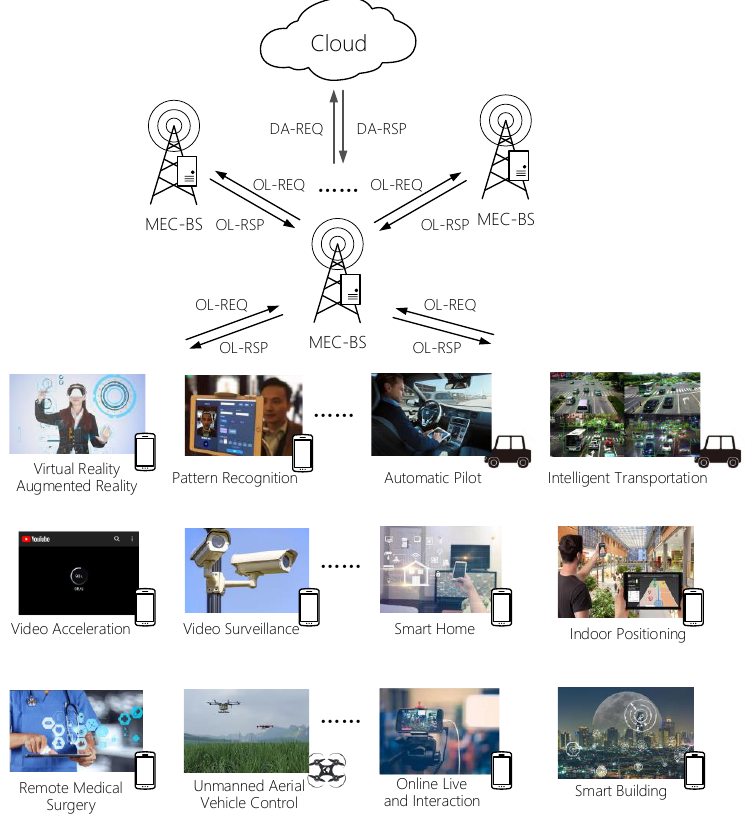
Figure 1. Offloading to MEC-BS, offloading to MEC-NBS, and executing in